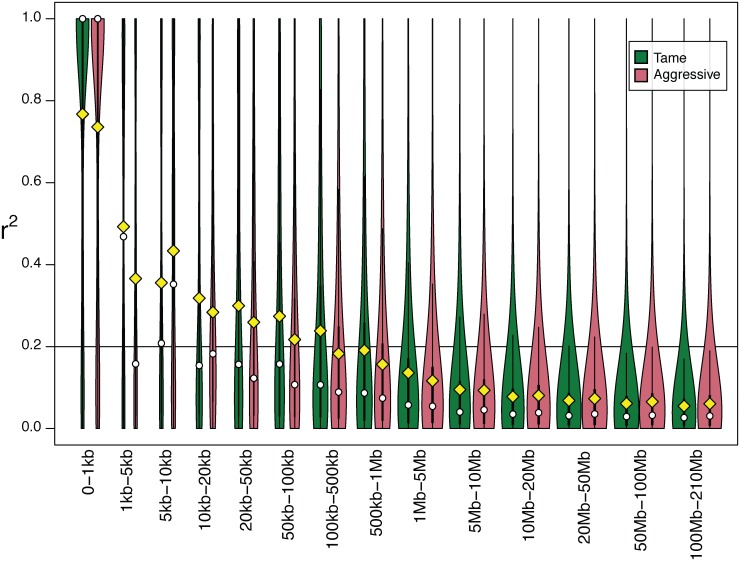
Estimation of linkage disequilibrium (r2) in tame and aggressive fox populations.Distributions of r2 values between pairs of SNPs separated by different distances are compared between tame (green) and aggressive (red) populations. SNP pairs were divided into 14 sets (bins) using the estimated distances between SNPs in the fox genome (S2 Table). Each bin is represented by a doubled bar (green and red) on the graph. The range of distances between SNPs in each bin is indicated on the x-axis. The width of the bar represents the relative number of SNP pairs in that bin for that population after a log transformation (wider bars have more pairs of SNPs). Exact numbers of SNP pairs in each bin are presented in S2 Table. The y-axis indicates r2 values for pairs of SNPs. The yellow diamonds correspond to the mean r2 for all SNPs in that bin in the population. The white circles correspond to the median values. The thin black line within each bar represents r2 values in that bin in the population in the interval from the 25th to 75th percentile. The horizontal line corresponds r2 = 0.2.